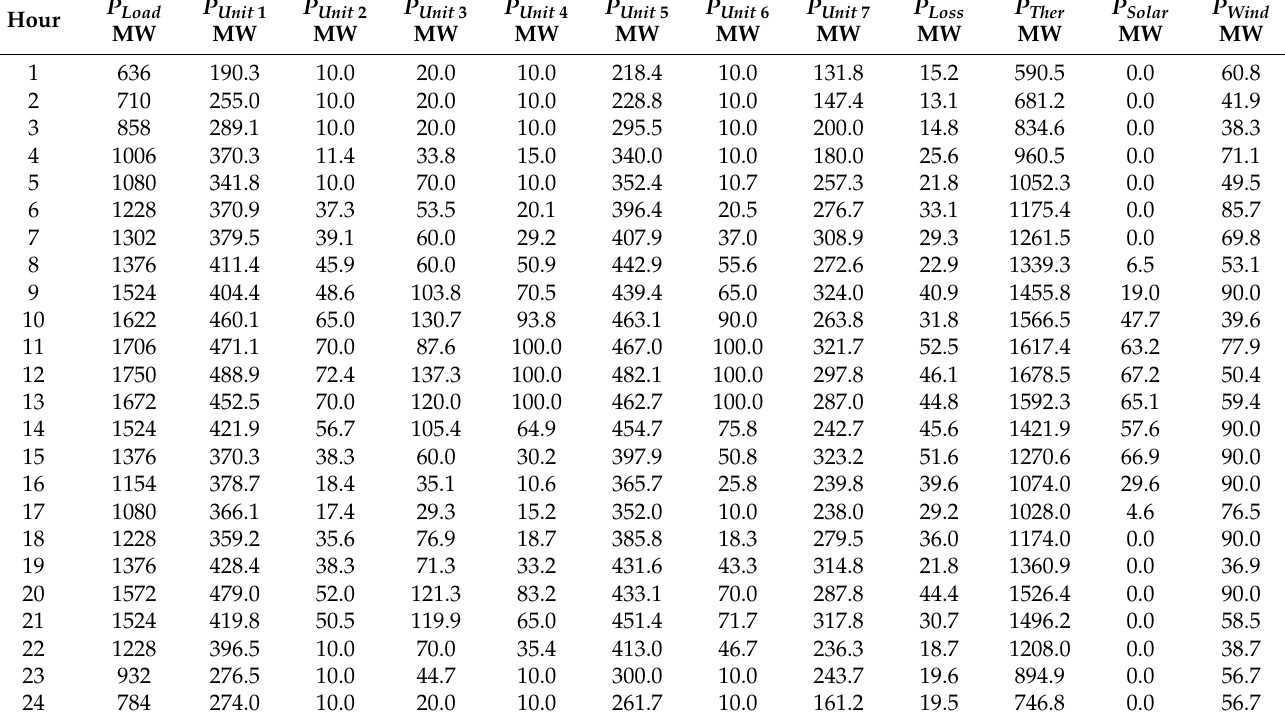
Table 26. Hourly load demand and power generation—case study 3.